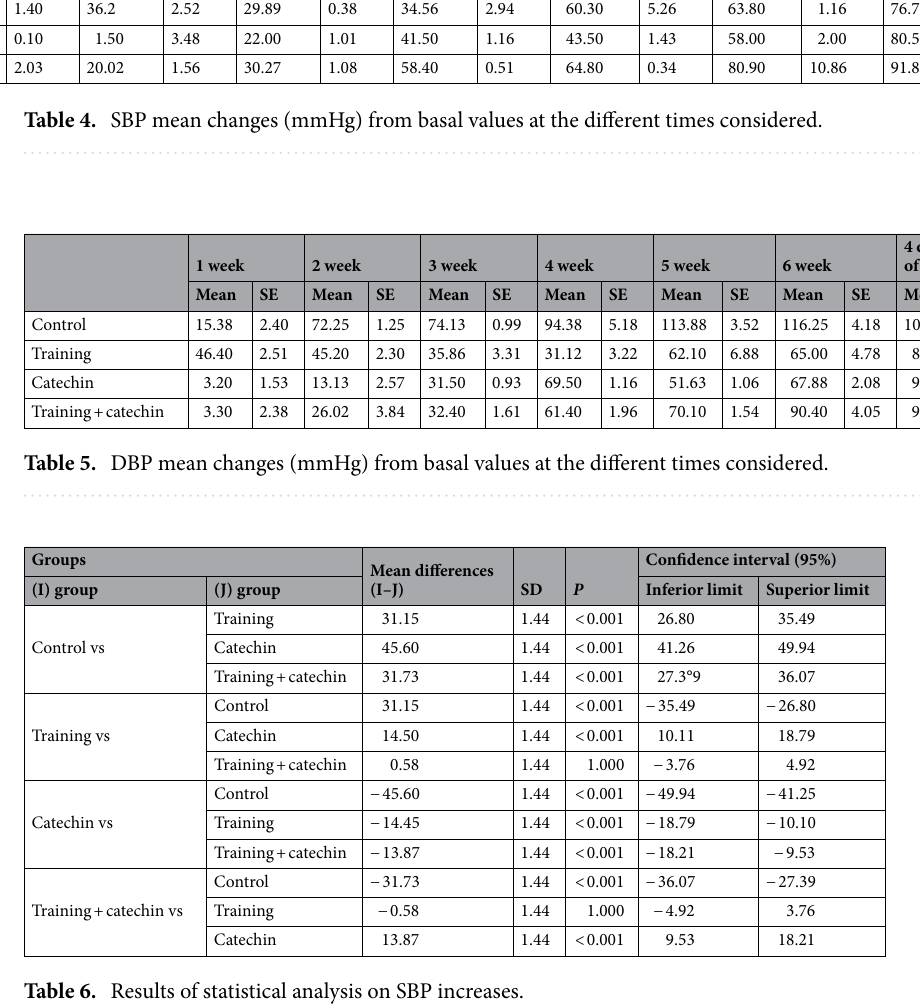
Table 6. Results of statistical analysis on SBP increases.